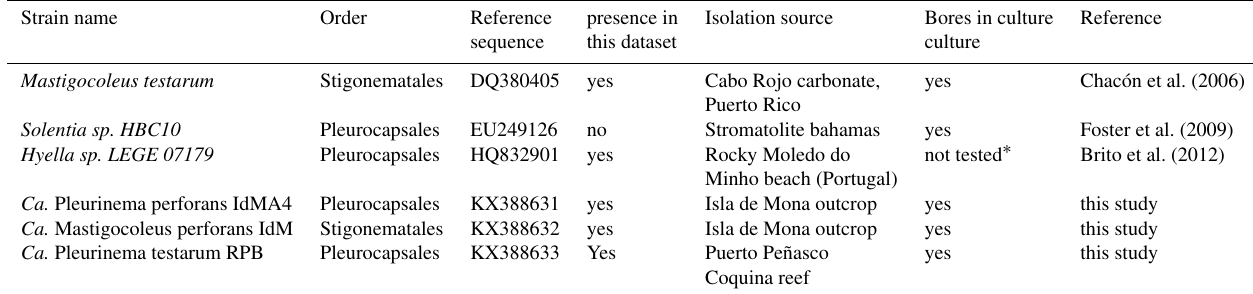
Table 1. Euendolithic cyanobacterial strains used to assign potential roles to OTUs.